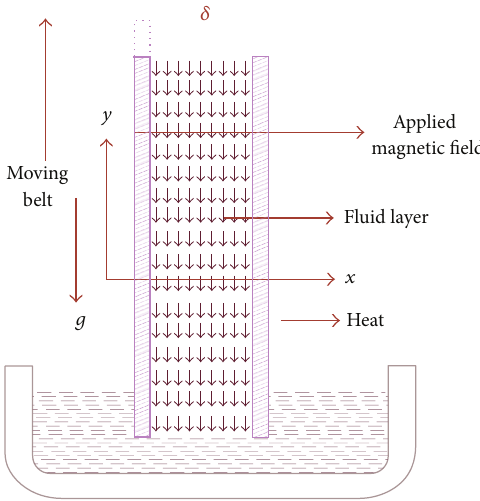
Figure 1: Geometry of the lifting